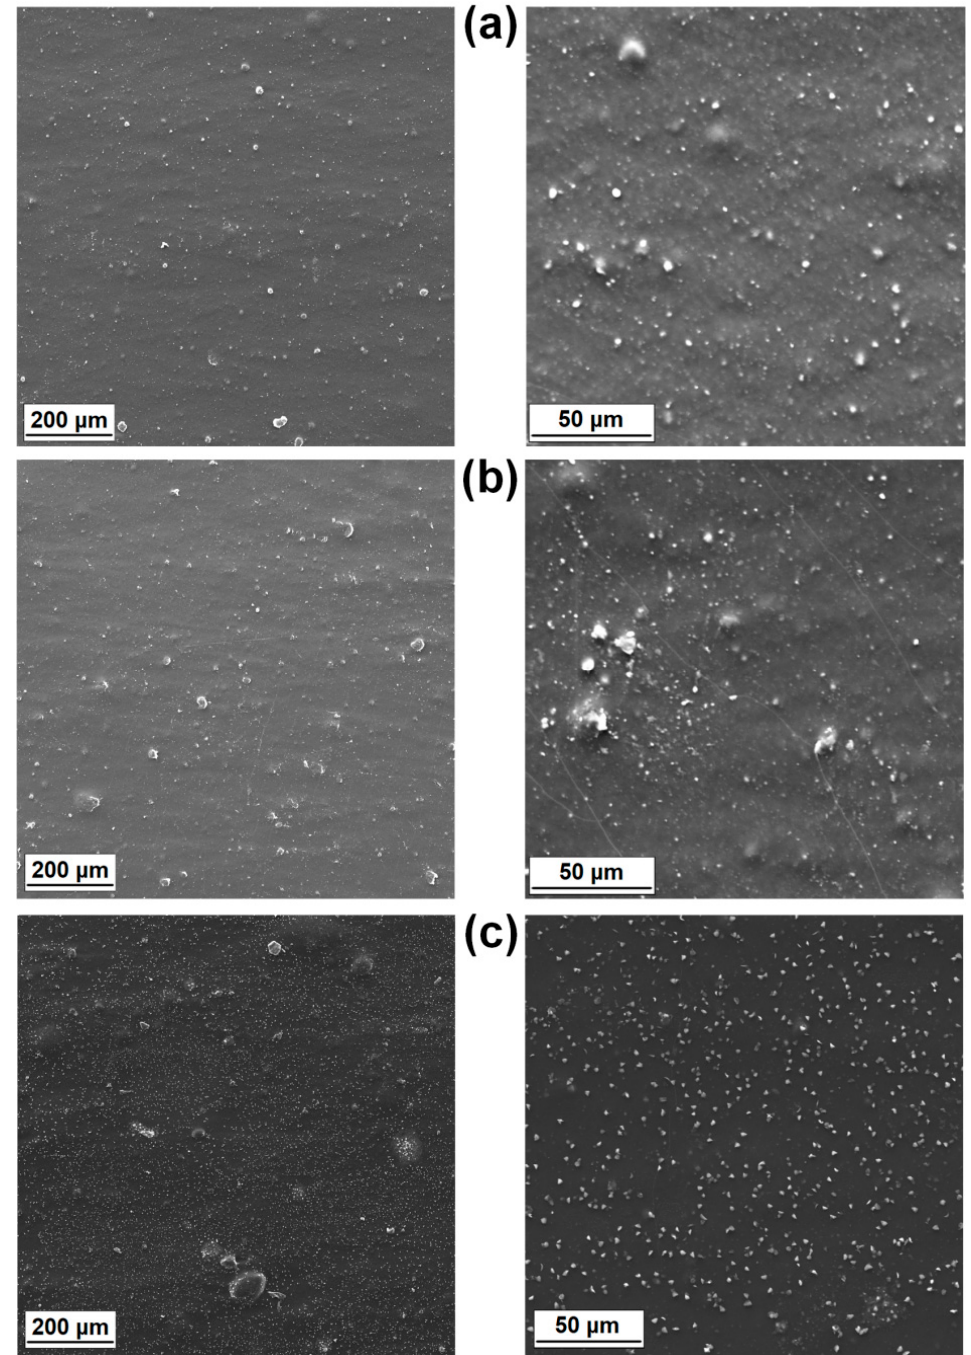
Figure 6. Representative SEM images of composite films: ( a ) LDPE/MgO-L (5:1 wt/wt), ( b ) LDPE/MgO-L (1:1 wt/wt), and ( c ) LDPE/MgO-L (1:5 wt/wt).